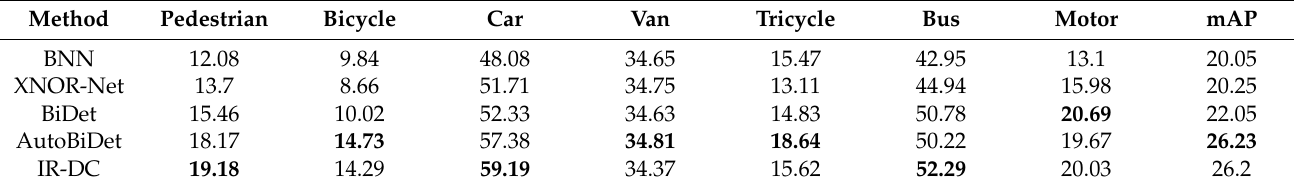
Table 10. Results of